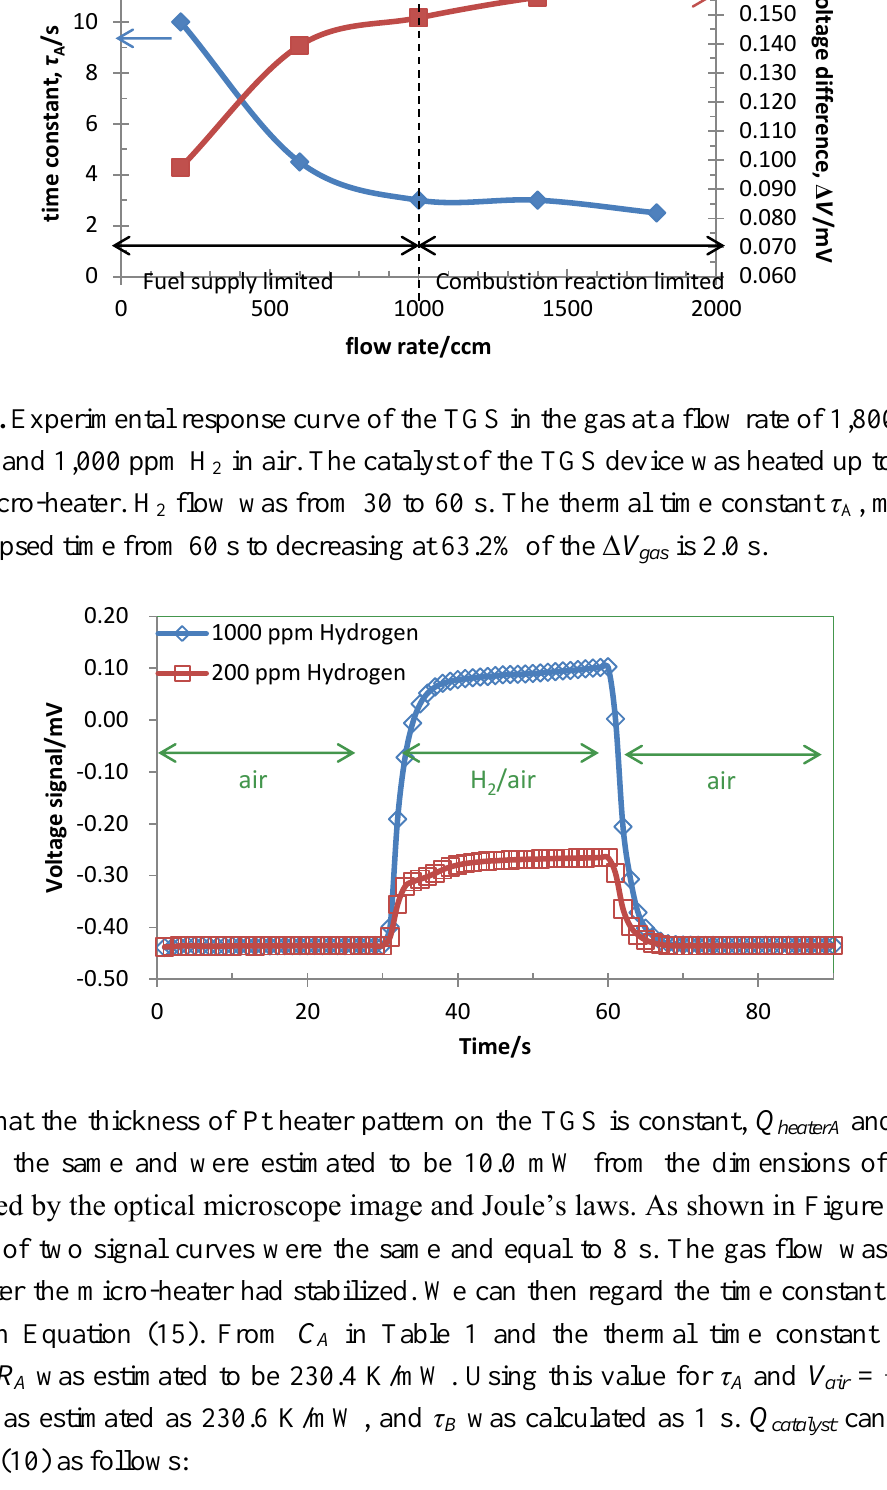
Figure 3. The flow rate dependence of the time constant, τ , and the voltage difference, Δ V , at the TGS for 200 ppm H in air and the flow rate from 200 ccm to 1,800 ccm. gas 2